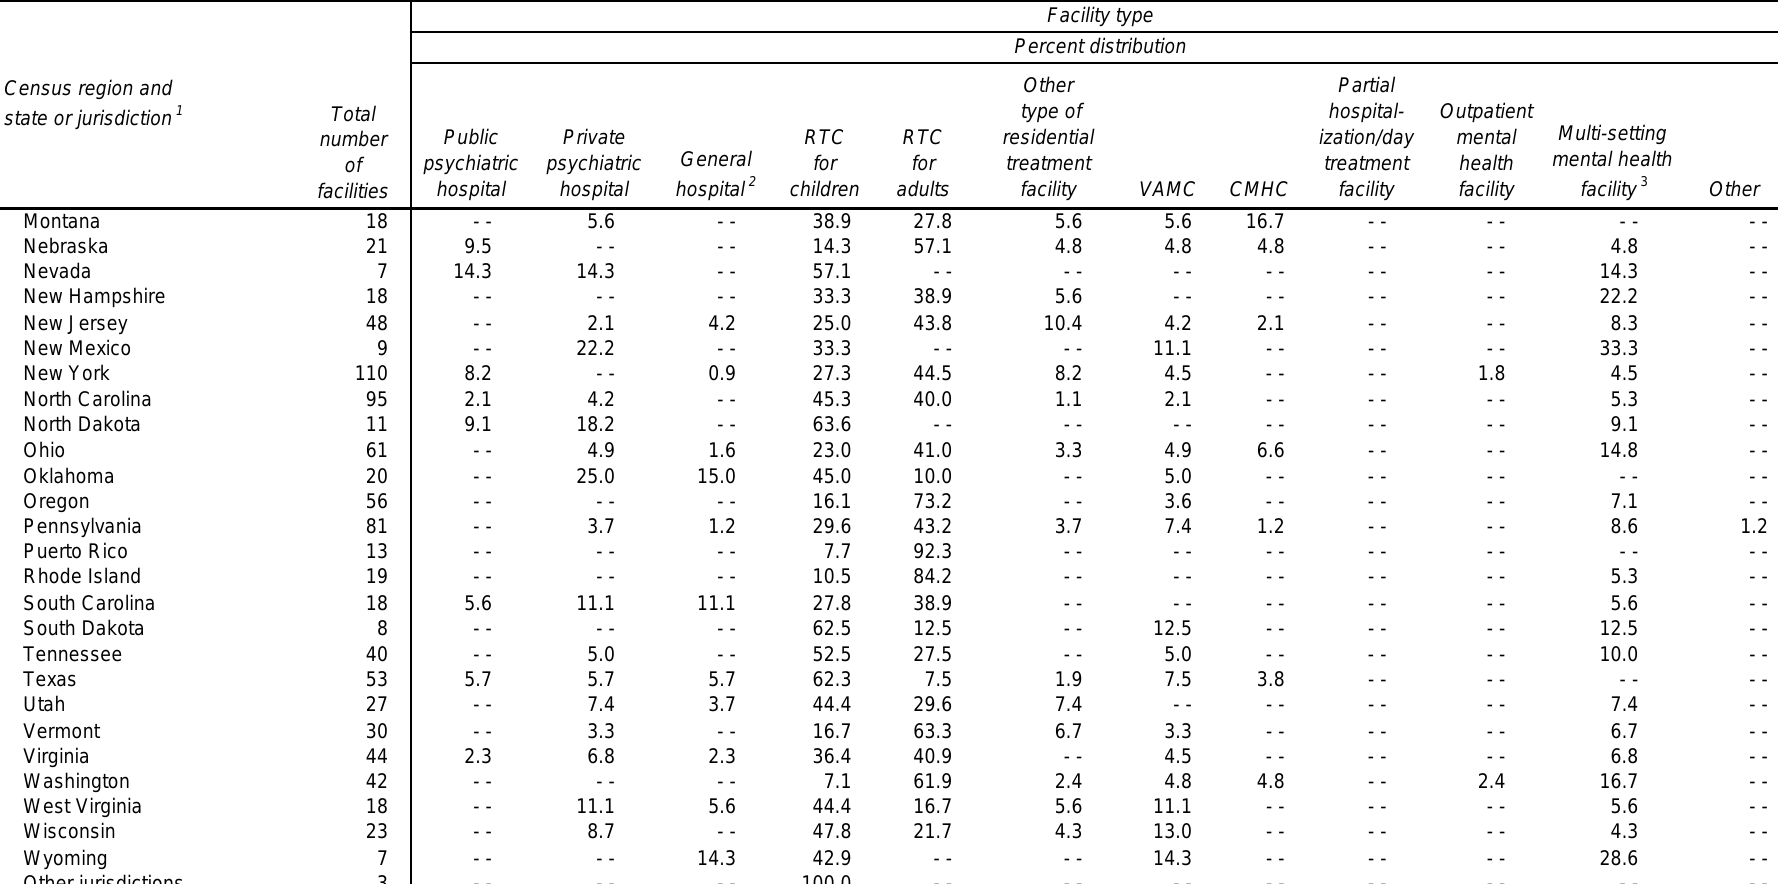
Table 3.4b. Mental health treatment facilities providing 24-hour residential treatment, by facility type, Census region, and state or